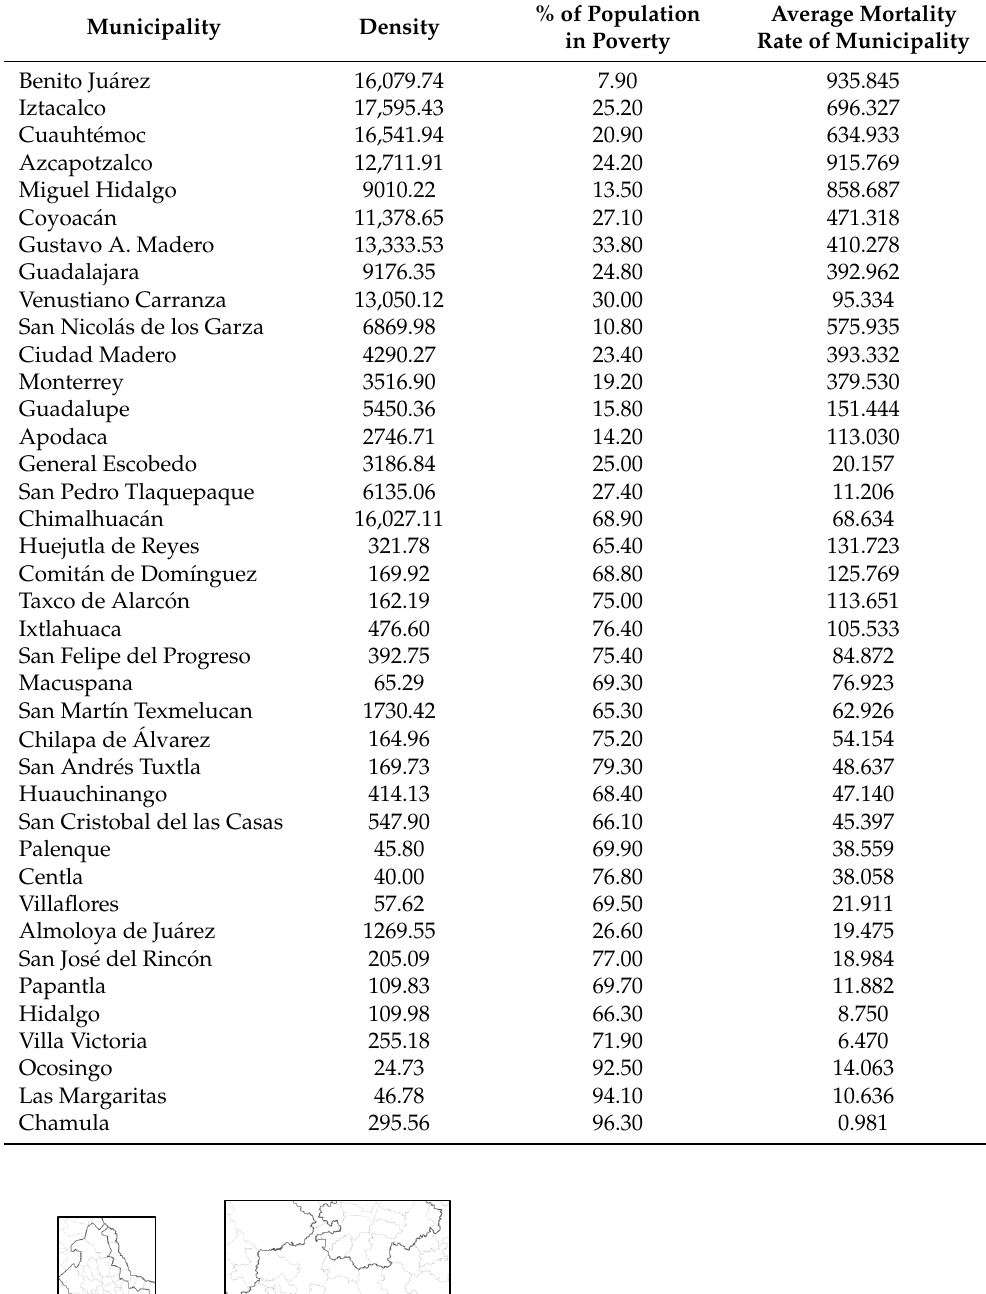
Table 6. Municipalities in each of the extreme clusters.